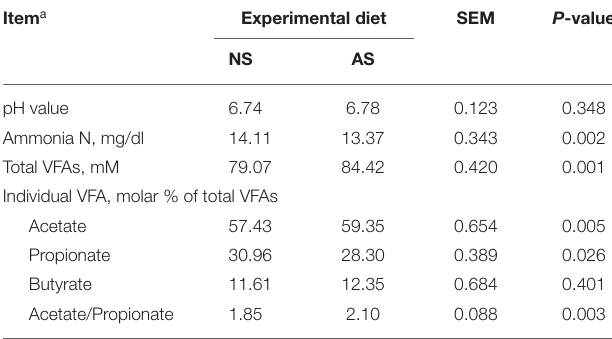
TABLE 3 | Rumen fermentation of goats fed a total mixed ration supplemented with Napier grass silage (NS) or anthocyanin-rich black cane silage